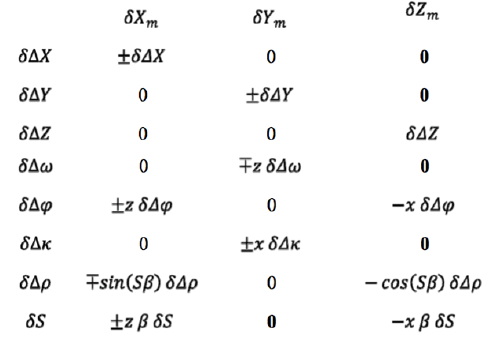
Table 1: Effects of Biases on Each Component of the Reconstructed Coordinate